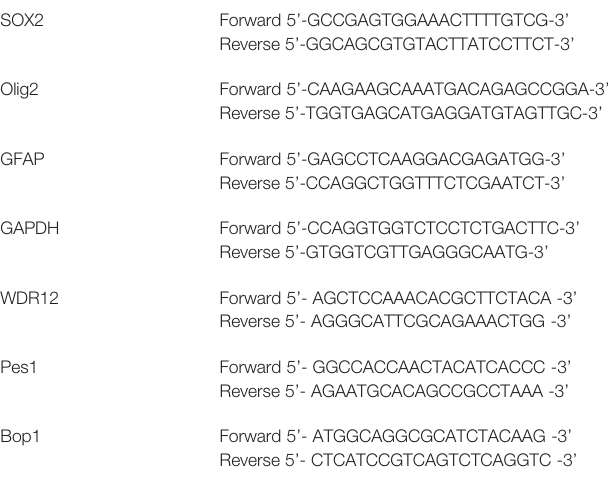
TABLE 1 | Primer sequences used for Real-Time